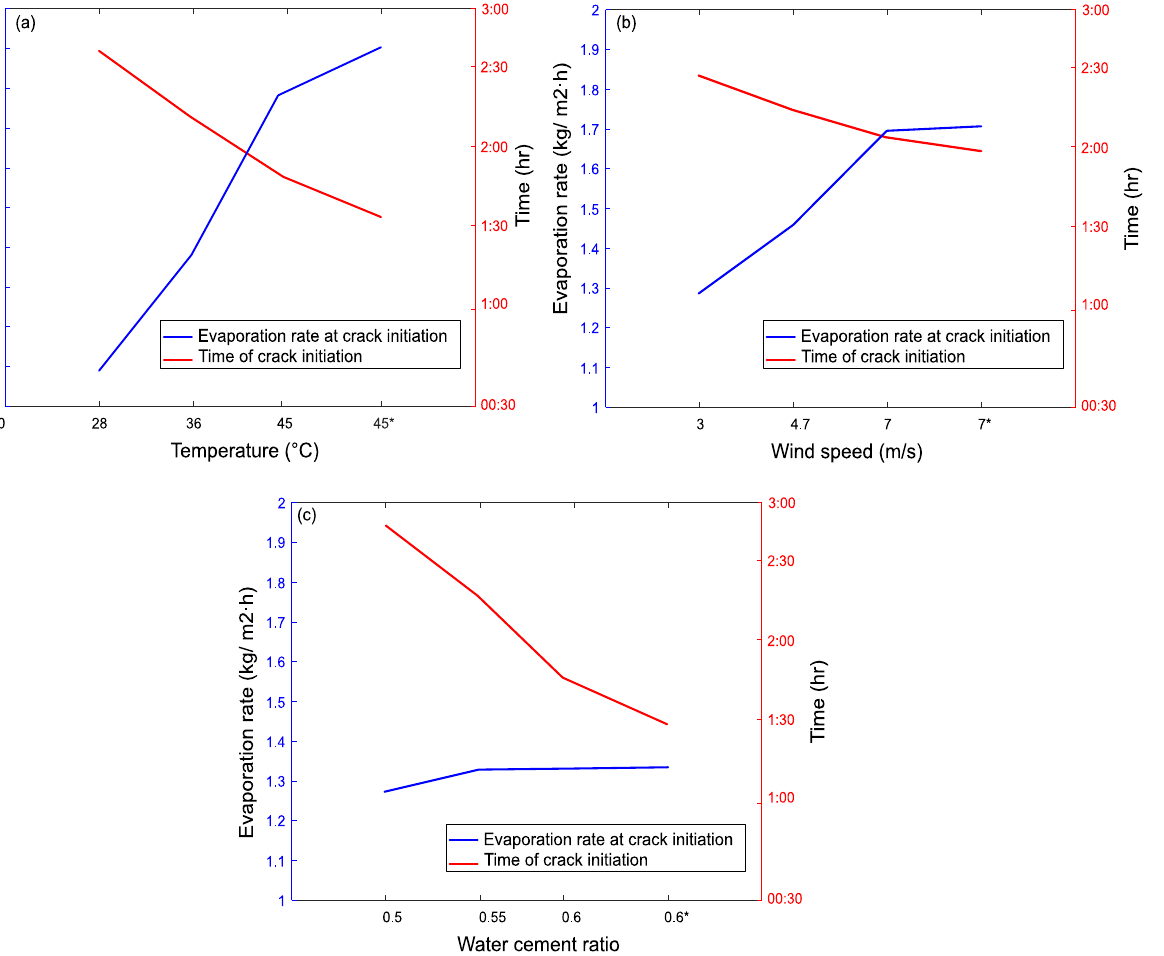
Figure 15. Effect of ( a ) temperature; ( b ) wind speed; and ( c ) w/c ratio on evaporation rate at crack initiation and time of crack initiation. * higher content of RTSF (40 kg/m 3 ).